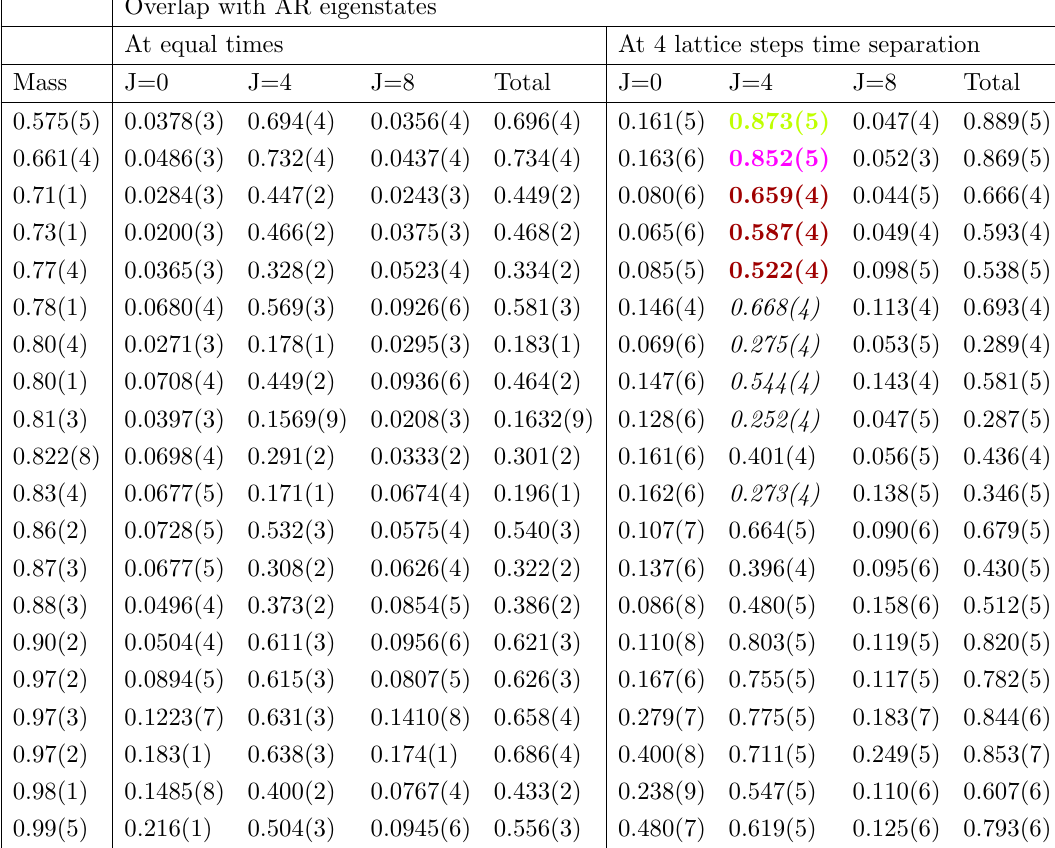
Table 12. Masses from glueballs in A 2 , C = + representations using conventional operators and overlaps with AR